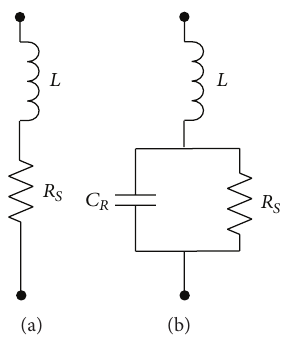
Figure 7: Equivalent circuit of a packaged PIN diode in its two-bias conditions; (a) ON - state (forward bias) and (b) OFF - state (reverse bias).